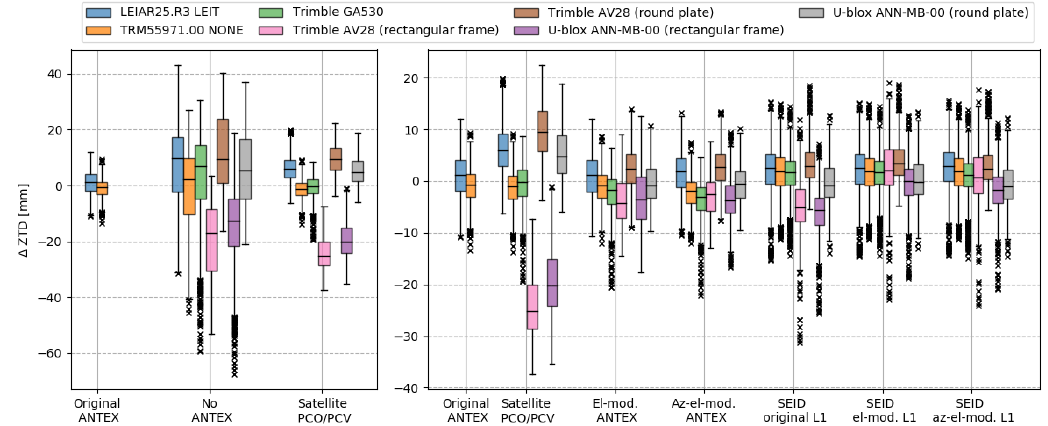
Figure 7. Boxplots of goGPS PPP ZTD estimations against IGS reference data from DLF1. The figure on the left depicts the combinations with the original dual-frequency RINEX data using the original IGS ANTEX file, supplying no ANTEX file at all, or only satellite PCO/PCV corrections. The boxplots on the right illustrate the references (original ANTEX, only satellite PCO/PCV), the results with original RINEX L1 + L2 and modified ANTEX entries (elevation modified ANTEX, azimuth-elevation modified ANTEX) and SEID results with original, elevation corrected and azimuth-elevation corrected L1